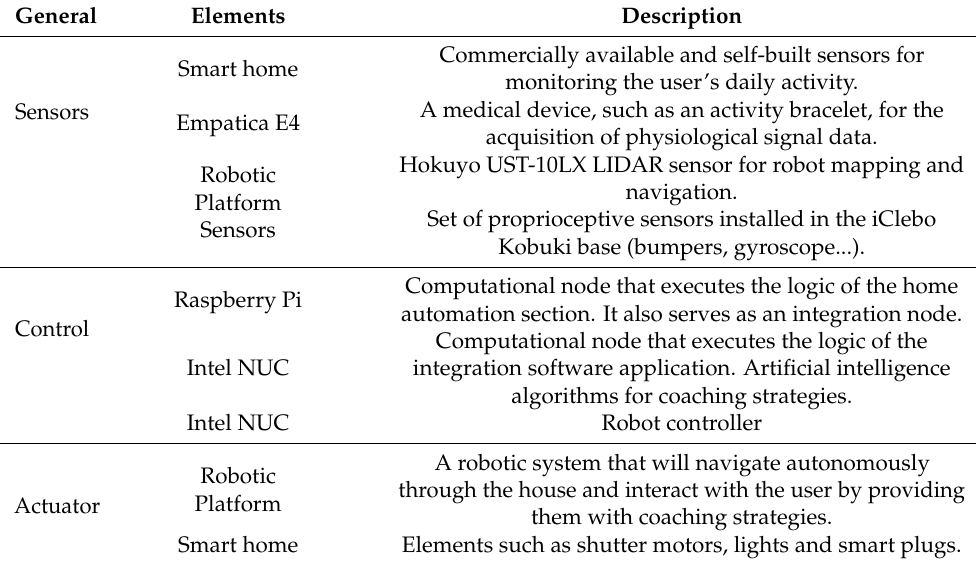
Table 1. General description of the system